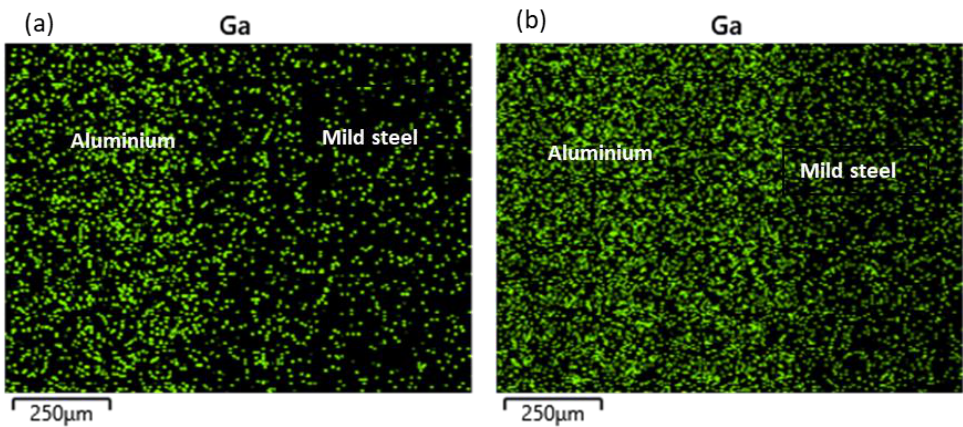
Figure 8. Elemental mapping of Gallium across the bonded metals: ( a ) Sample E; ( b ) Sample F.